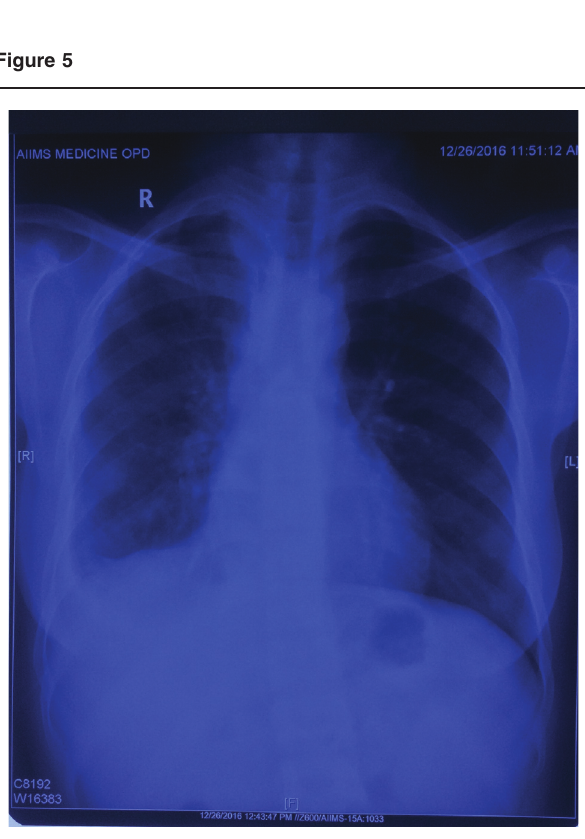
Chest radiography pretreatment. Chest radiography after 4 months of antitubercular